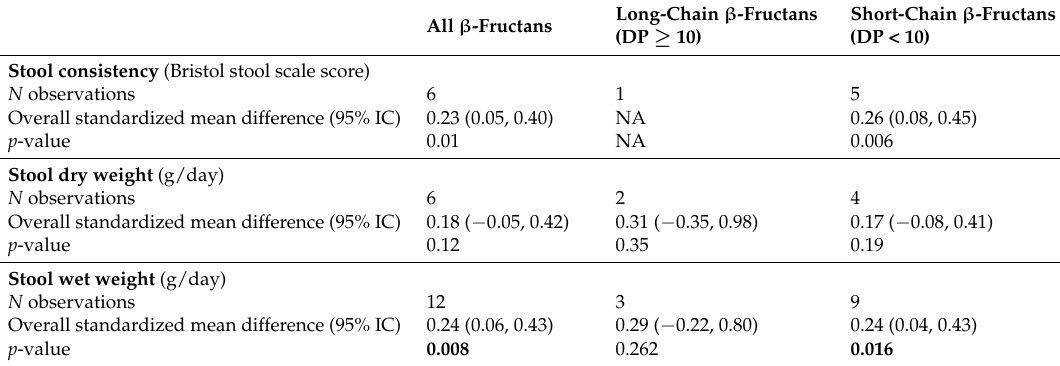
Table 2. Effect of β -fructans on stool consistency, fecal dry, and wet weights.